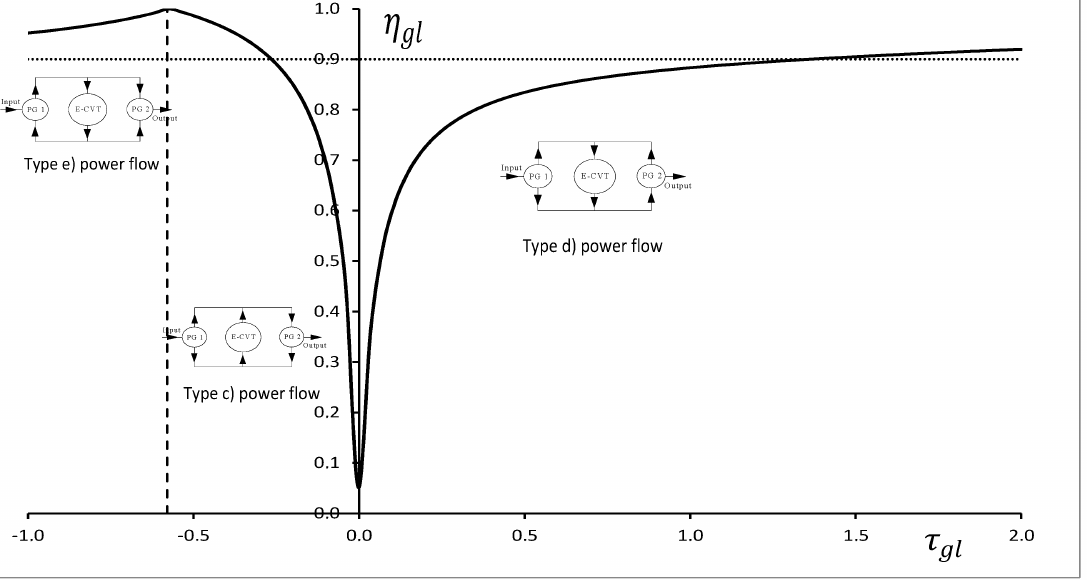
Figure 6. Global efficiency vs. global transmission